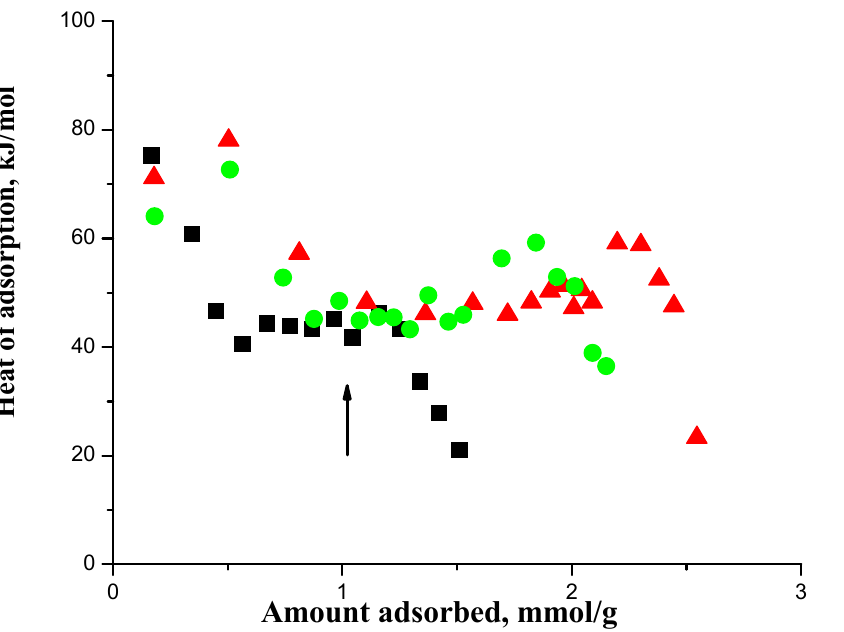
Figure 1. Heat of adsorption as a function of surface concentration of dimethyl ether on SAPO-34 zeolite at 25 °C ( ▲ ), 60 °C ( ● ) and 100 °C ( ■ ). The arrow indicates the acid site density, which is 1 mmol/g.